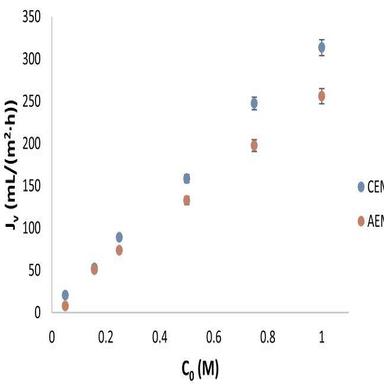
Osmotic flux vs. lower concentration determined for Type 10 Fujifilm membranes CEM and AEM.